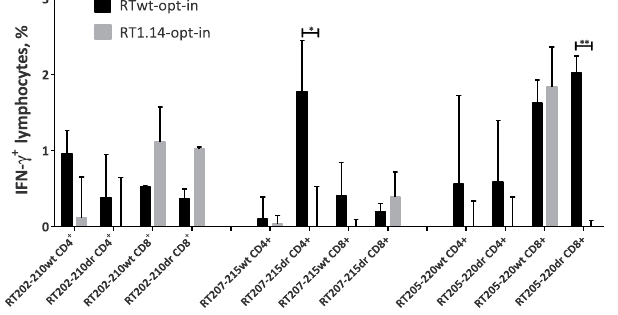
Figure 9. CD4 + and CD8 + epitope mapping in the 202–220 RT region as assessed by multiparametric FACS. Epitope mapping of CD4 + and CD8 + T-cell recognition by RTwt-opt-in and RT1.14-opt-in gene-immunized mice (pool of 5 mice) of aa 202–220 of RT with and without drug-resistance mutations (Table 1) assessed by multiparametric FACS with staining for CD4 + , CD8 + , and IFN- γ . Immune assays were performed following standard protocols on the murine splenocytes isolated 21 days after immunization with the RT gene. Assays were performed in duplicate. For the description of the immunization experiment, see the legend to Fig. 2 and “Materials and methods”. Responses are presented as the percentage of the reactive CD4 + and CD8 + cells producing IFN- γ , and error bars show the SD. * p < 0.05, ** p < 0.01. Statistical comparisons were performed using paired